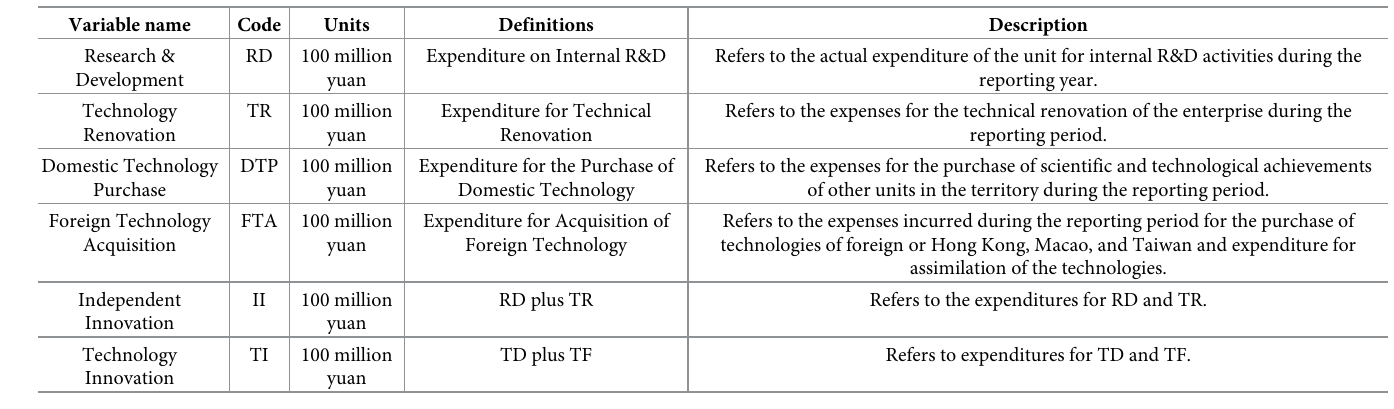
Table 3. Variables’ names, codes, units, definitions, and descriptions of all variables.